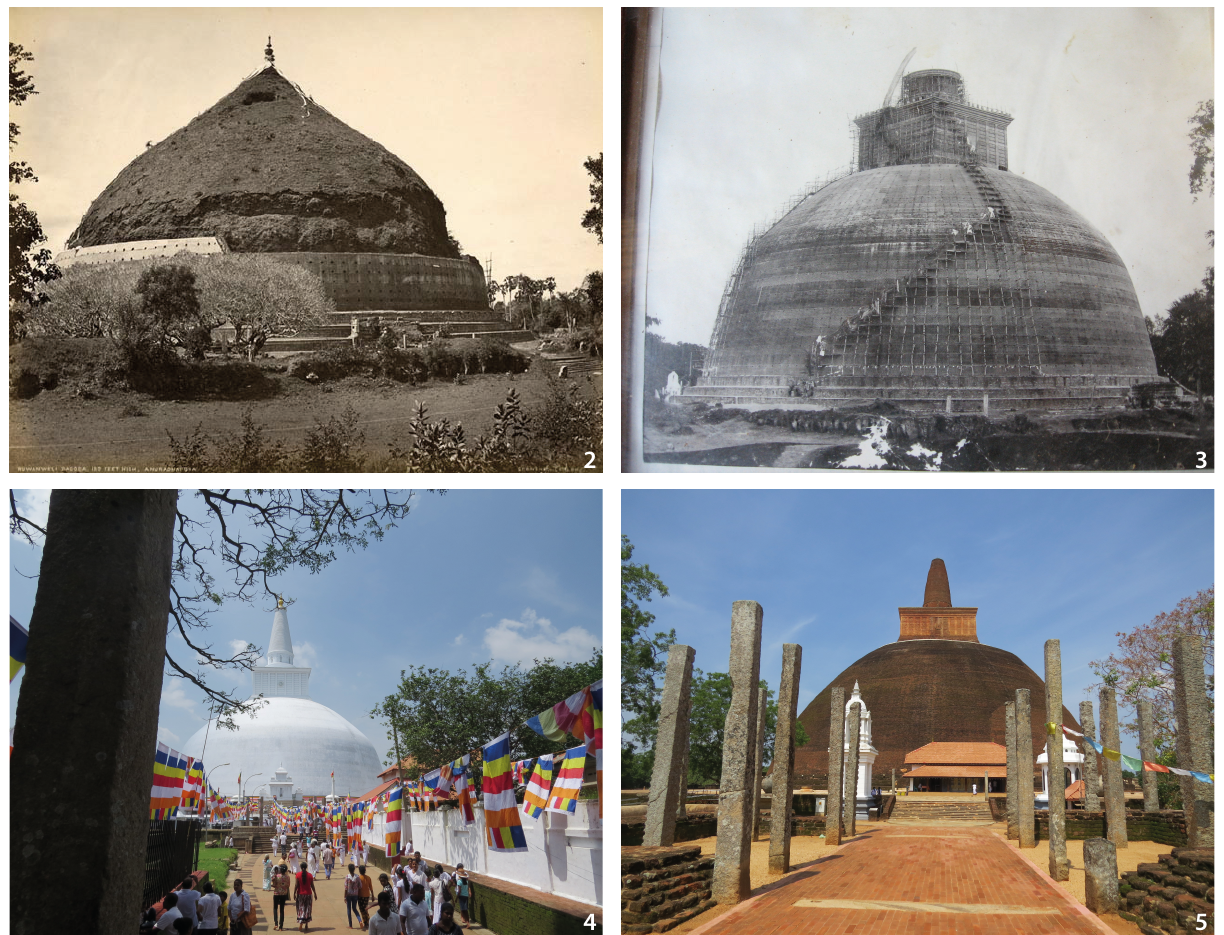
Figure 2 Ruwanweli Stupa (built in 1 st century BC abandoned during the colonial occupation) (Source: Department of Archaeology, Sri Lanka). Figure 3 Ruwanweli Stupa being restored 1940 (Source: Department of Archaeology, Sri Lanka). Figure 4 Ruwanweli Stupa at present (Source: Nilan Cooray). Figure 5 Abhayagiri Stupa (built in 1 st century BC) at present (Source: Nilan